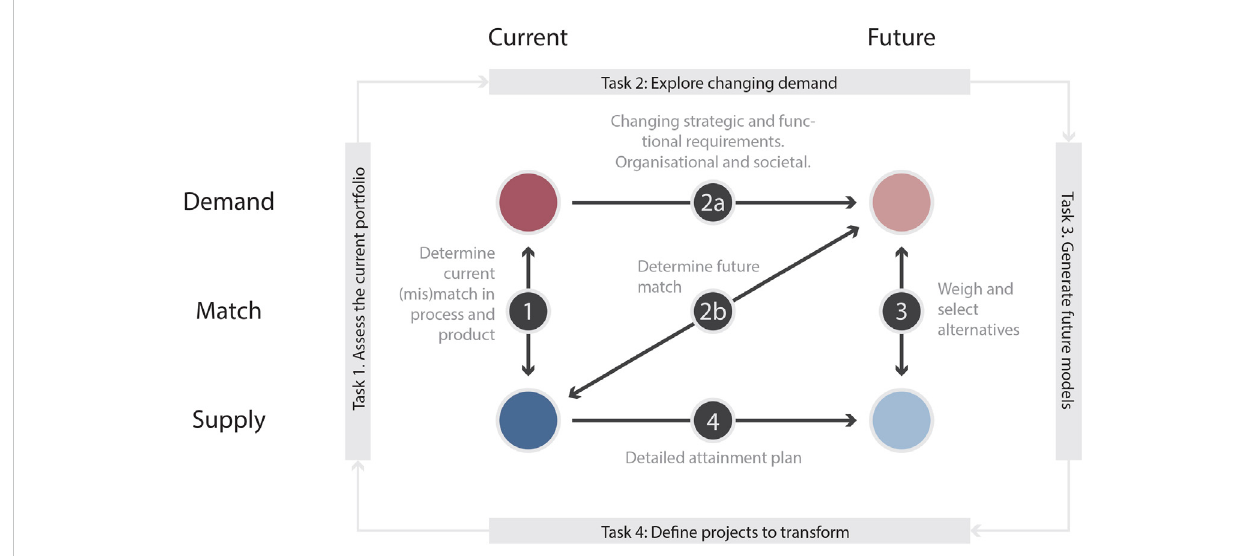
FIGURE 1 Designing an Accommodation Strategy (DAS) in fi ve steps. Adapted from (De Jonge et al., 2009; den Heijer, 2011).